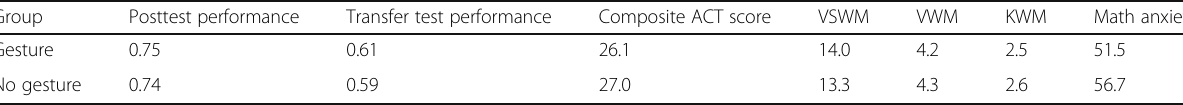
Table 1 Mean performance on measures by group Group Posttest